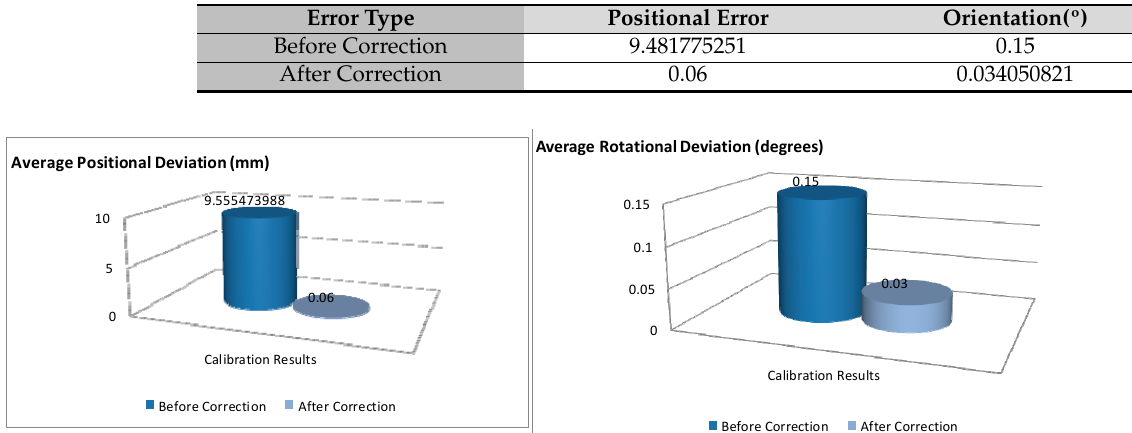
Table 3. Error between desired and measured pose on fourth correction cycle .